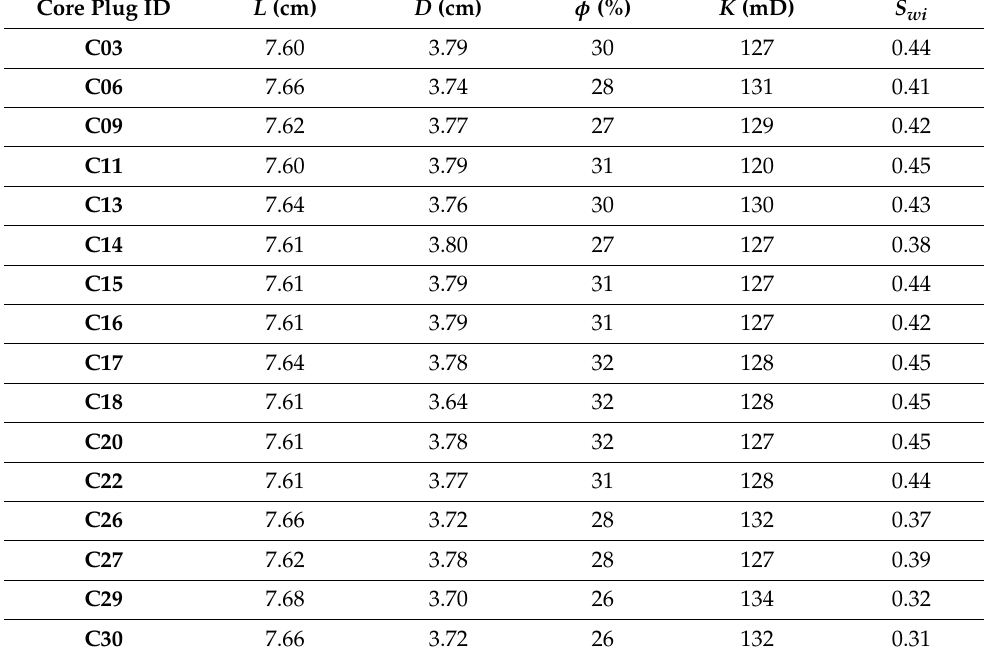
Table 1. Properties of rock samples used in this study. Here: L is length, D is diameter, φ is porosity, K is absolute permeability, and S wi is initial water saturation in core flooding experiments. Typical experimental error inclusive of instrument accuracy and repeatability is permeability and porosity, respectively.